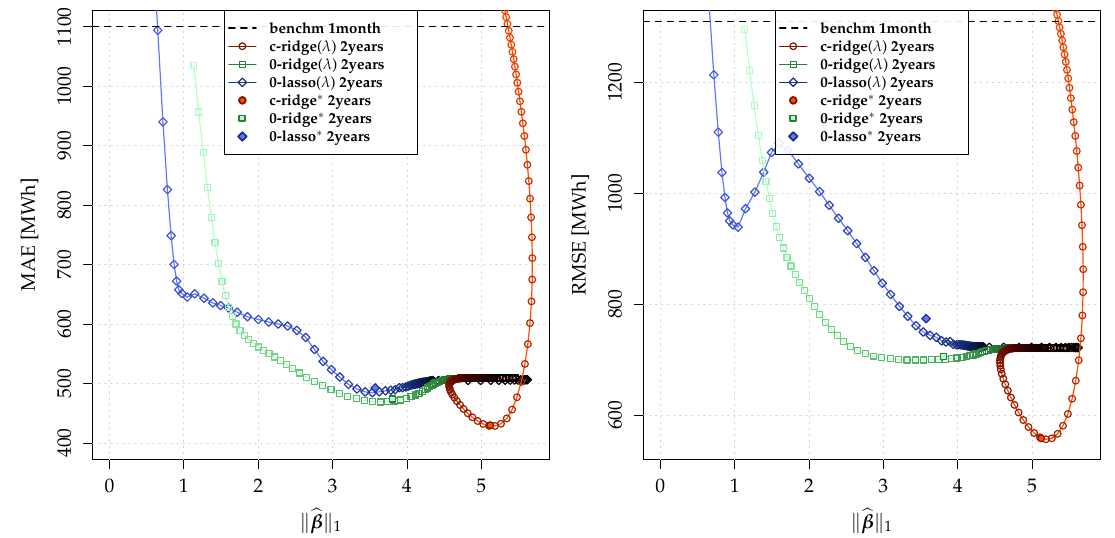
against MAE (left) and RMSE (right) of the selected lasso and ridge models, Figure 4. Graph of (cid:98) β (cid:107) (cid:107) 1 illustrating the solution paths for different λ values. The darker the color, the smaller the shrinkage (black = OLS).